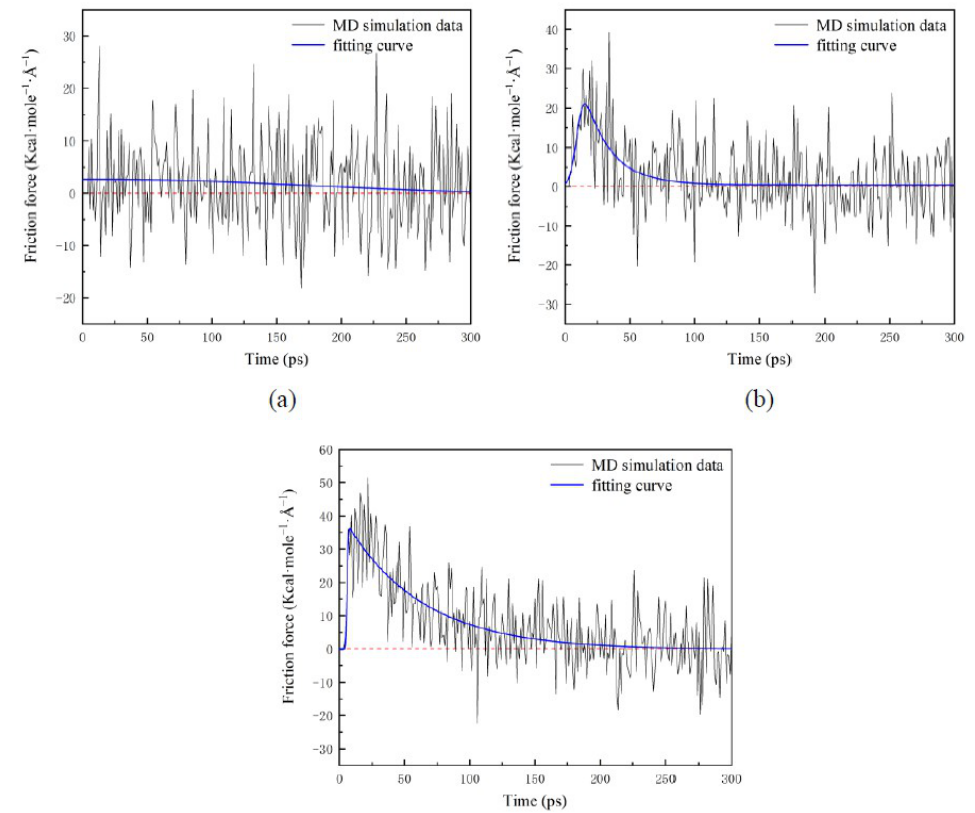
Figure 7. Time evolution of the friction force applied to droplets: ( a ) V s = 0.5 Å/ps; ( b ) V s = 3 Å/ps; ( c ) V s = 9 Å/ps.